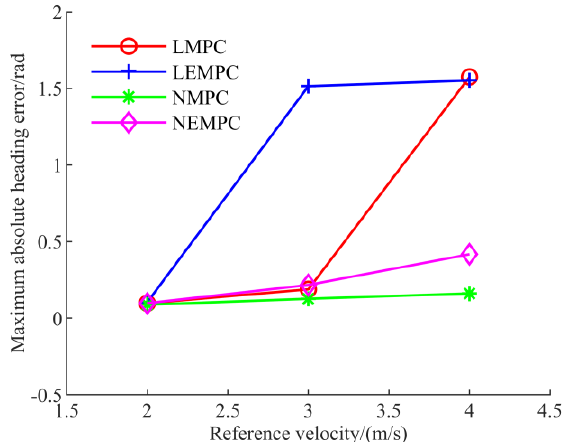
Figure 20. The trend of the maximum absolute heading error.